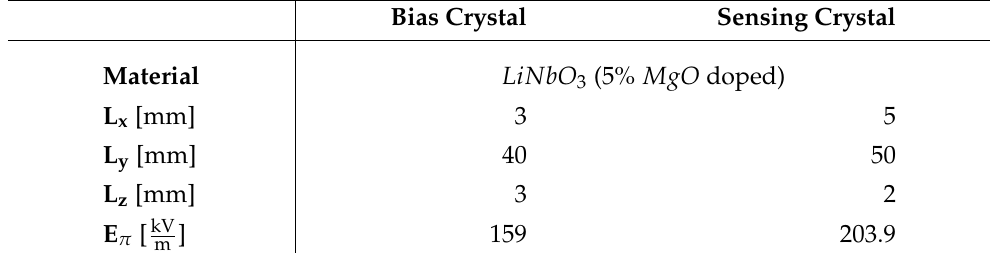
Table 1. Properties of the crystals used in the EO